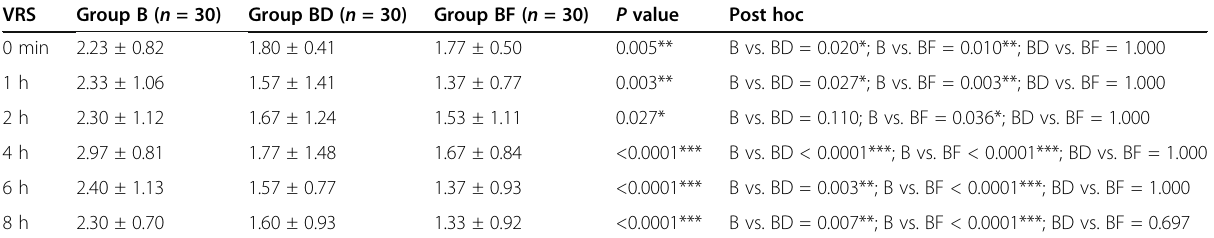
Table 3 Comparison of pain scores at different time intervals